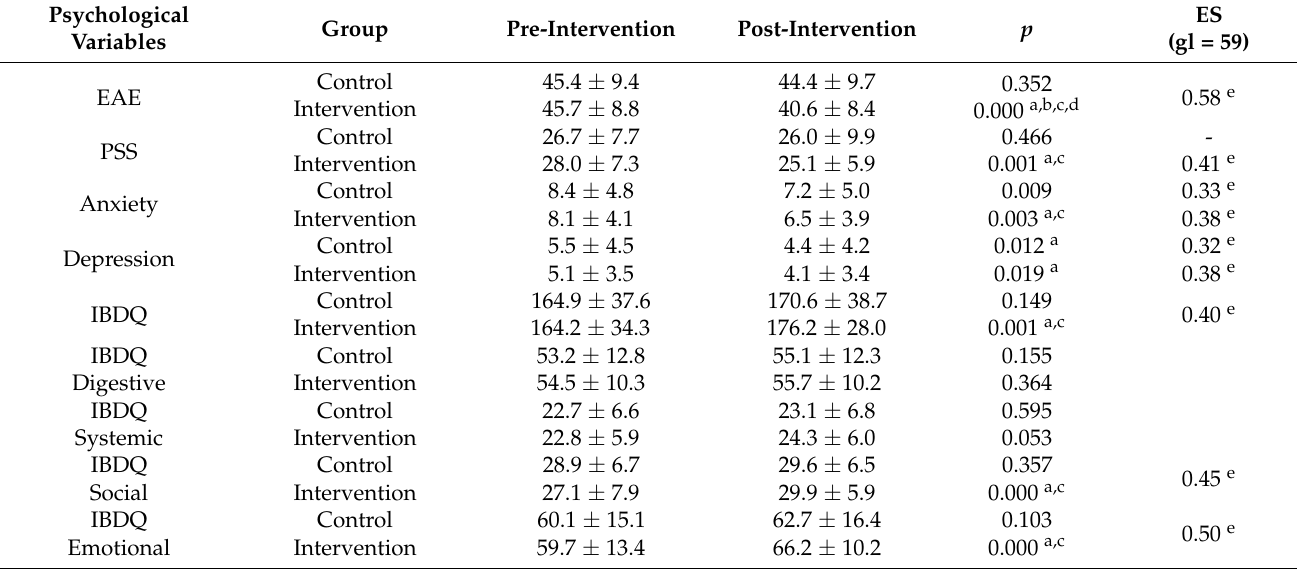
Table 2. Effectiveness of the group psychological intervention program on psychological variables and quality of life. Psychological